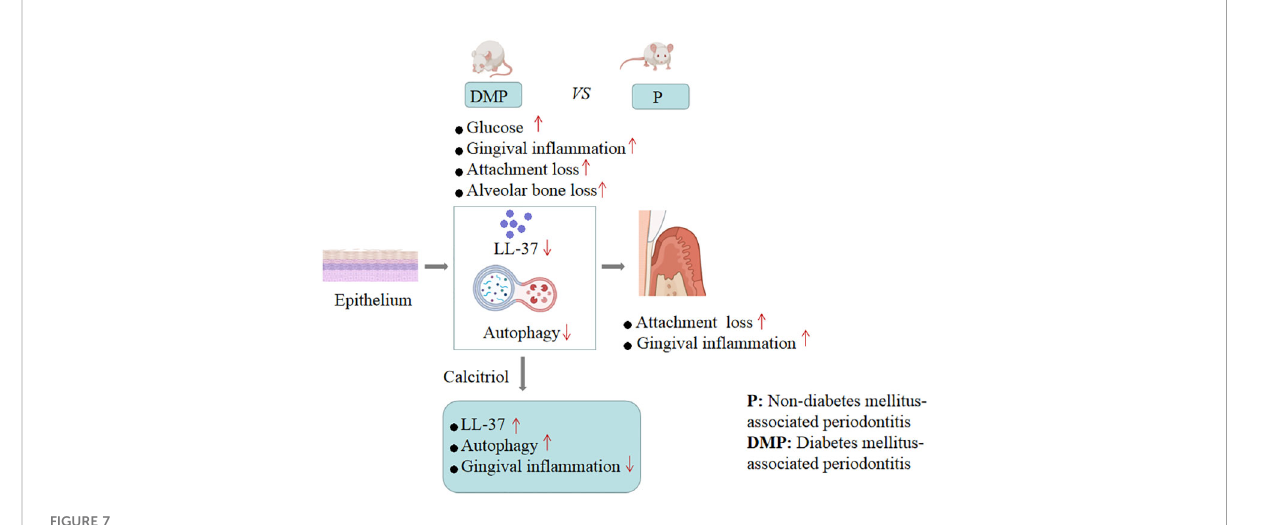
FIGURE 7 Mechanism schema